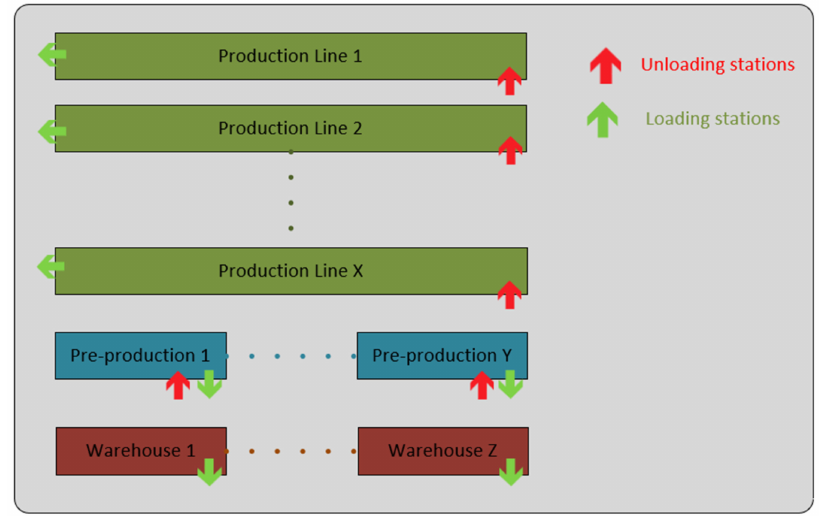
Figure 5. Simple layout of loading/unloading stations for AGV.